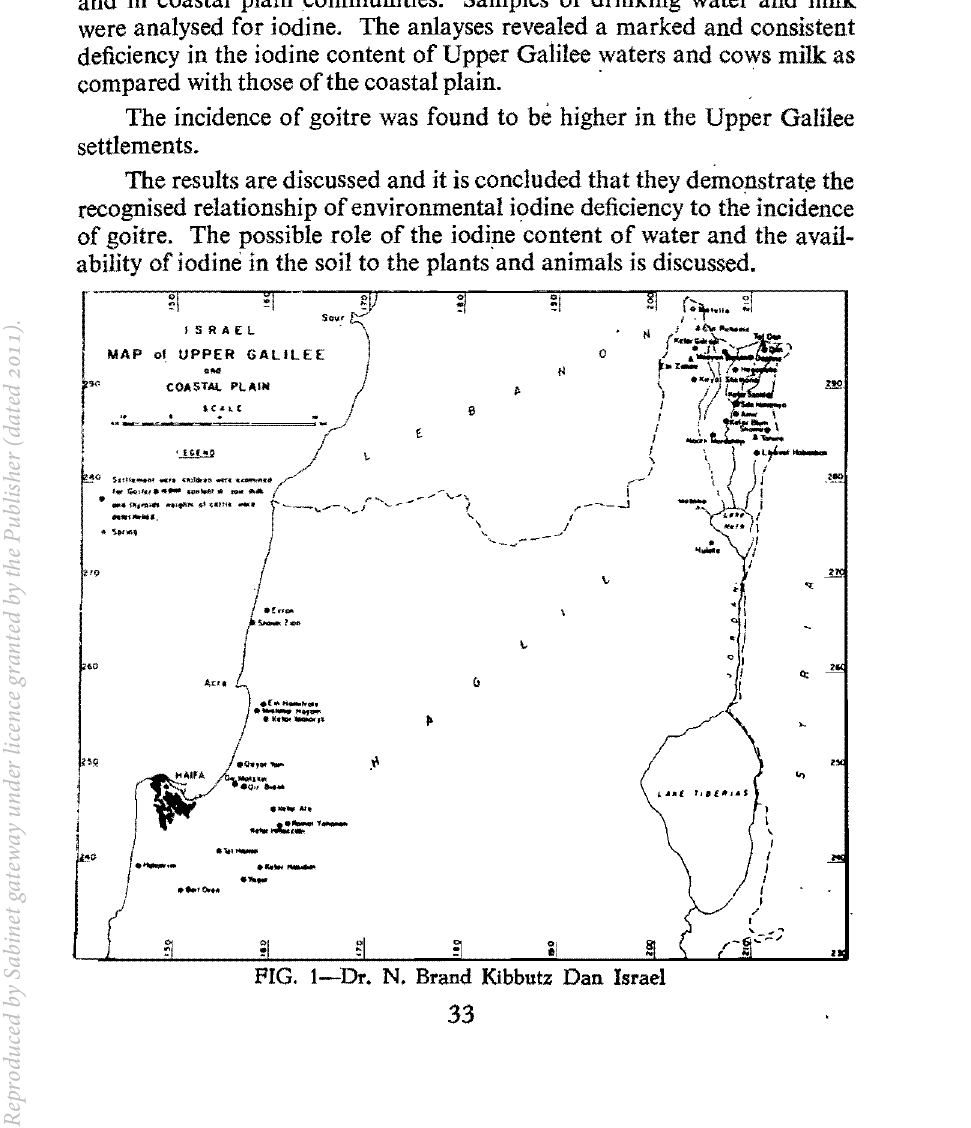
FIG. I-Dr. N. Brand Kibbutz Dan